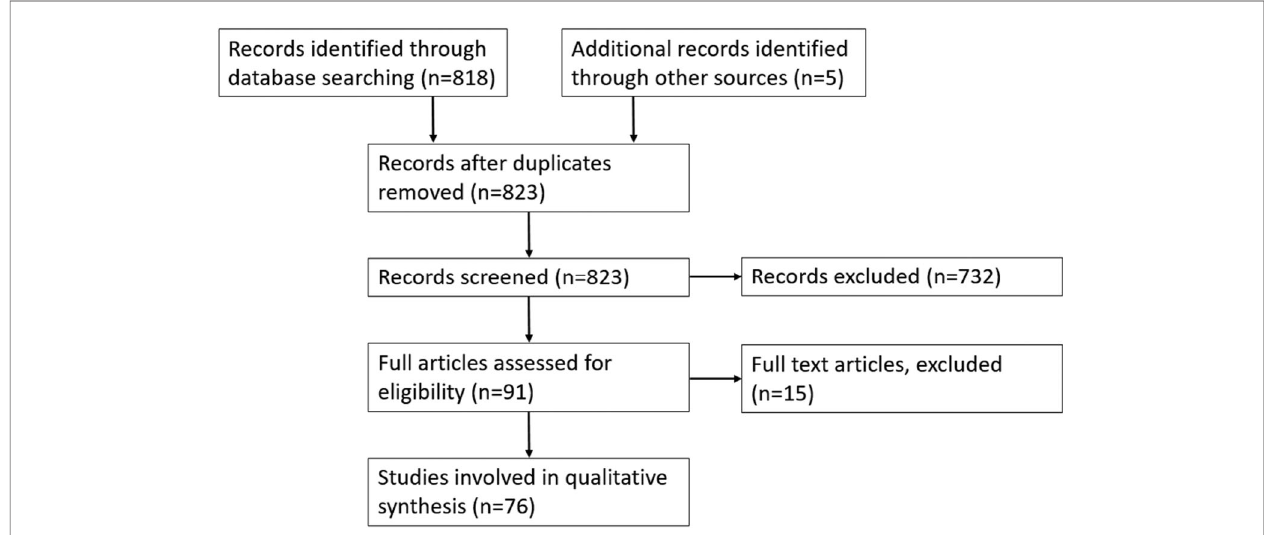
FIGURE 1 | Flow diagram of records involved in analysis of animal scar